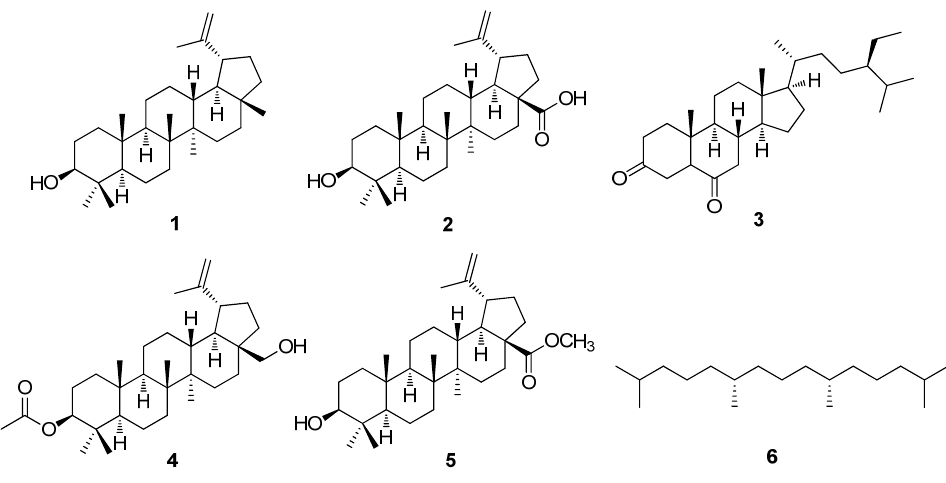
Figure 4. Chemical structure of compounds 1 – 6 .